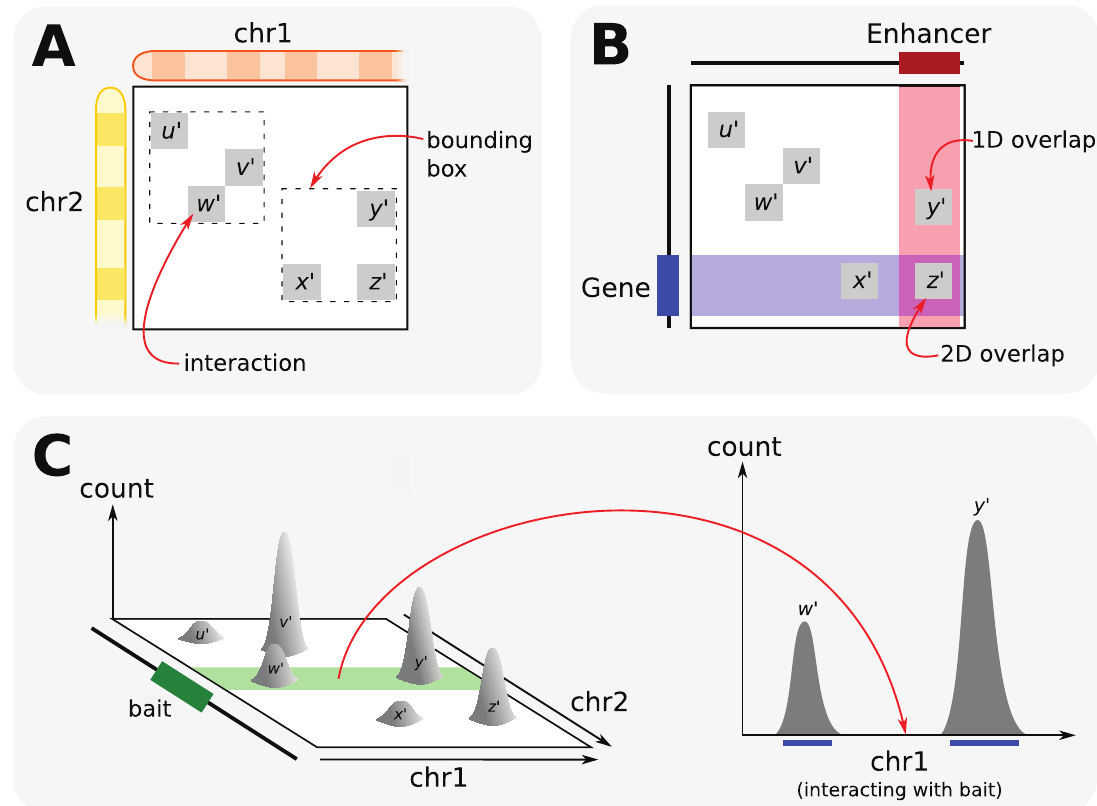
Figure 2. Schematic of several methods in the InteractionSet package. ( A ) Minimum bounding boxes can be identified for groups of interactions using the boundingBox method. Here, u ′ , v ′ and w ′ belong in one group while x ′ , y ′ and z ′ belong in another. ( B ) One- or two-dimensional overlaps can be identified between interactions and one or two genomic intervals, respectively, using the findOverlaps method. Here, x ′ and y ′ have one-dimensional overlaps with the gene and enhancer, respectively, while z ′ has a two-dimensional overlap with the gene and the enhancer. ( C ) An InteractionSet object contains data – in this case, read pair count data – for interactions in the two-dimensional interaction space. Given a bait region, a “cross-section” of the space can be extracted and converted into a RangedSummarizedExperiment object using the linearize method. This object holds count data for intervals on the linear genome (blue lines) where the count for each interval describes the strength of the interaction between that interval and the bait. This format effectively mimics that of 4C